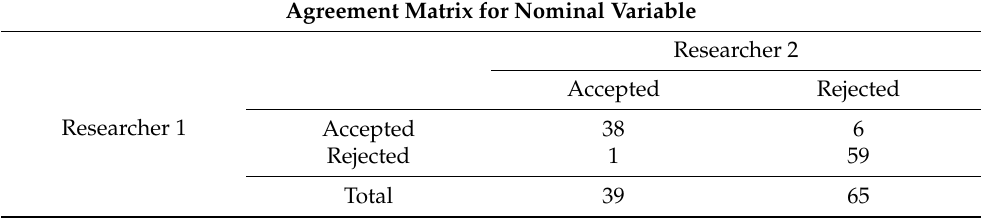
Table 5. Agreement matrix for nominal variable.